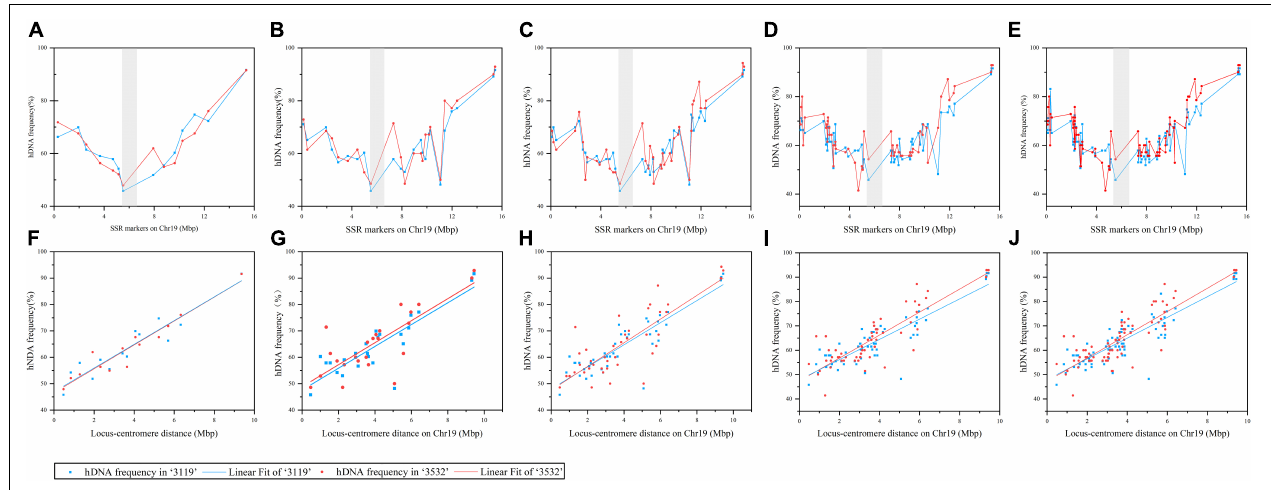
FIGURE 1 | The frequency of heteroduplex DNA (hDNA) and the correlation between it and locus-centromere distance on chromosome 19 under different markers detected. The gray shadow indicated putative centromeres position on Chr19,which is between 5.3 and 6.7 Mbp (Xin et al., 2018). (A–E) Represented the distribution of hDNA frequency on Chr19 under 14, 24, 41, 60, and 79 markers detected, respectively; and (F–J) indicated the correlation analysis between hDNA frequency and locus-centromere distance on chromosome 19 under 14, 24, 41, 60, and 79 markers detected, respectively.